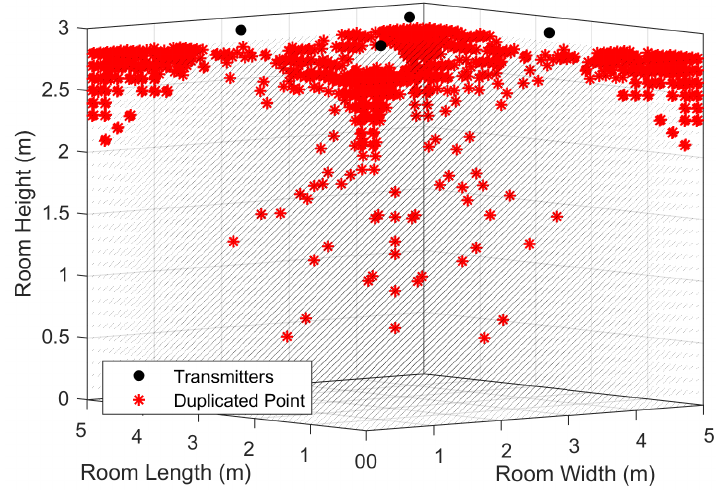
Figure 6. A demonstration of the duplicated points in the